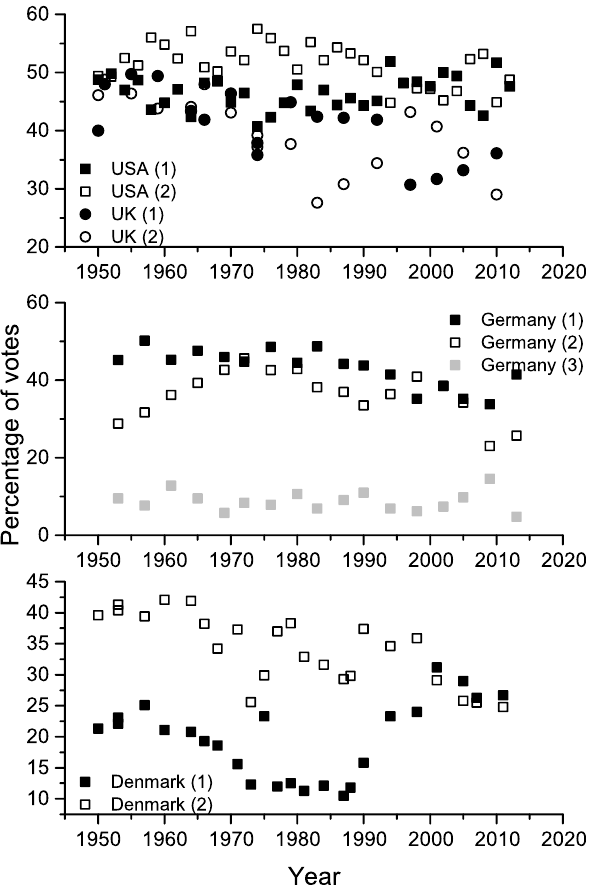
Fig. 1. The percentage support for di®erent parties in several countries. Upper plot: USA (squares), United Kingdom (circles), middle plot: Germany, lower plot: Denmark. The countries are grouped according to their election system. The names of particular parties are not presented, they are distin- guished only by